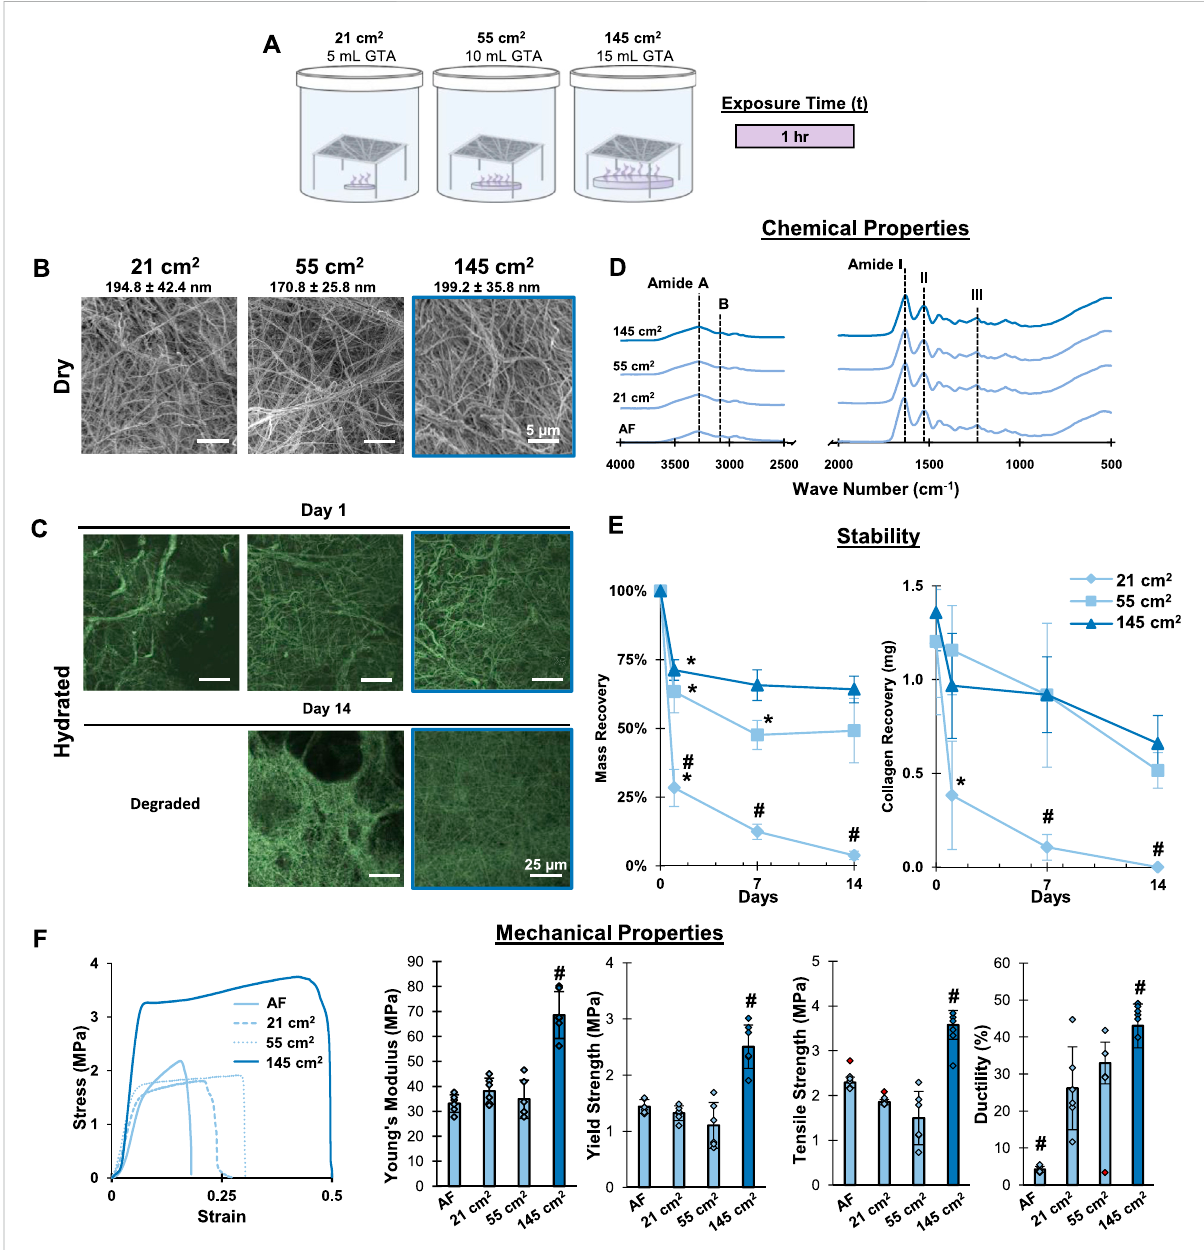
FIGURE 3 Mesh Fabrication: Crosslinking Surface Area. Crosslinking with the 145 cm 2 surface are a bath for 1 hour stabilizes gelatin meshes and enhances tensile properties without changing fi ber morphology, chemistry, or causing pits/voids in the mesh surface. (A) Schematic of the crosslinking procedure. (B) Dry morphology (SEM, 2,500x) and (C) hydrated morphology (CRM, 100x) of meshes after crosslinking. (D) Chemical composition(FTIR-ATR). (E) Meshstability bymass recovery and collagenrecoveryafterincubation at37 ° C in cellculture medium(14 days, n = 5). (F) Mesh tensile properties with representative stress-strain curves ( n = 10). Red markers represent outliers. AF=As fabricated. #= p < 0.05 between groups. *= p < 0.05